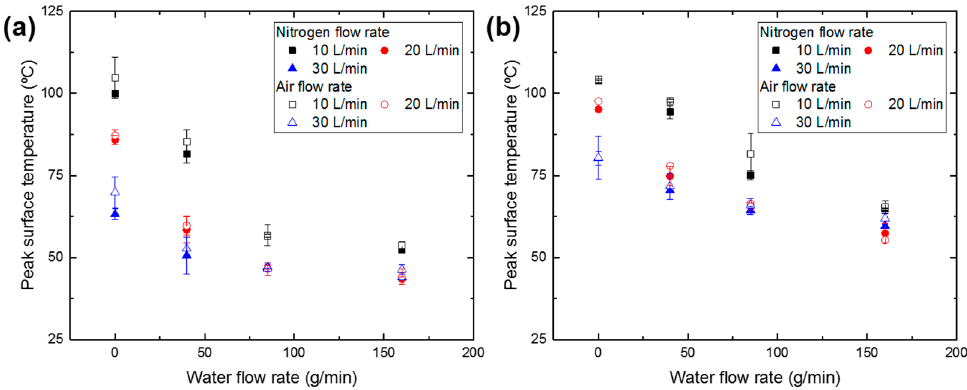
Figure 11. Peak surface temperature for nitrogen and air: ( a ) HRR = 1.17 kW and ( b ) HRR = 5.23 kW.